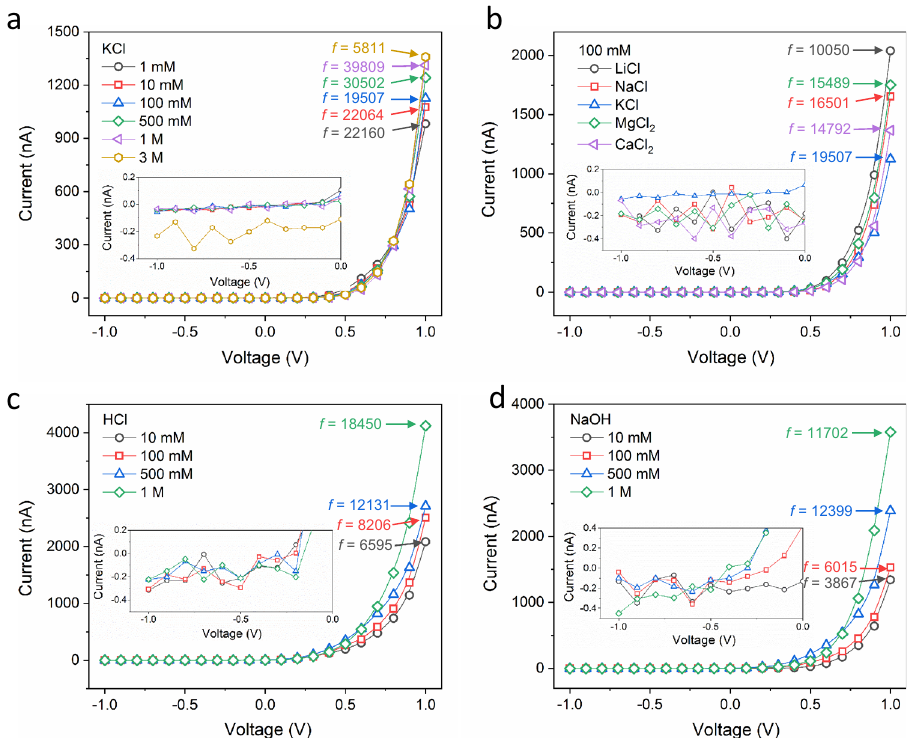
Fig. 2 Ion transport properties and calculated recti fi cation ratios. Typical current – voltage curves in ( a ) KCl electrolyte with concentrations from 1 mM to 3 M; ( b ) various electrolytes with concentration of 100 mM; ( c ) HCl solutions with various concentrations from 10 mM to 1 M; and ( d ) NaOH solutions with various concentrations from 10 mM to 1 M. The numbers ( f ) represent the calculated recti fi cation ratio. The measured error bar is below 1% and therefore not plotted. Error bars represent standard deviations from fi ve independent experiments.